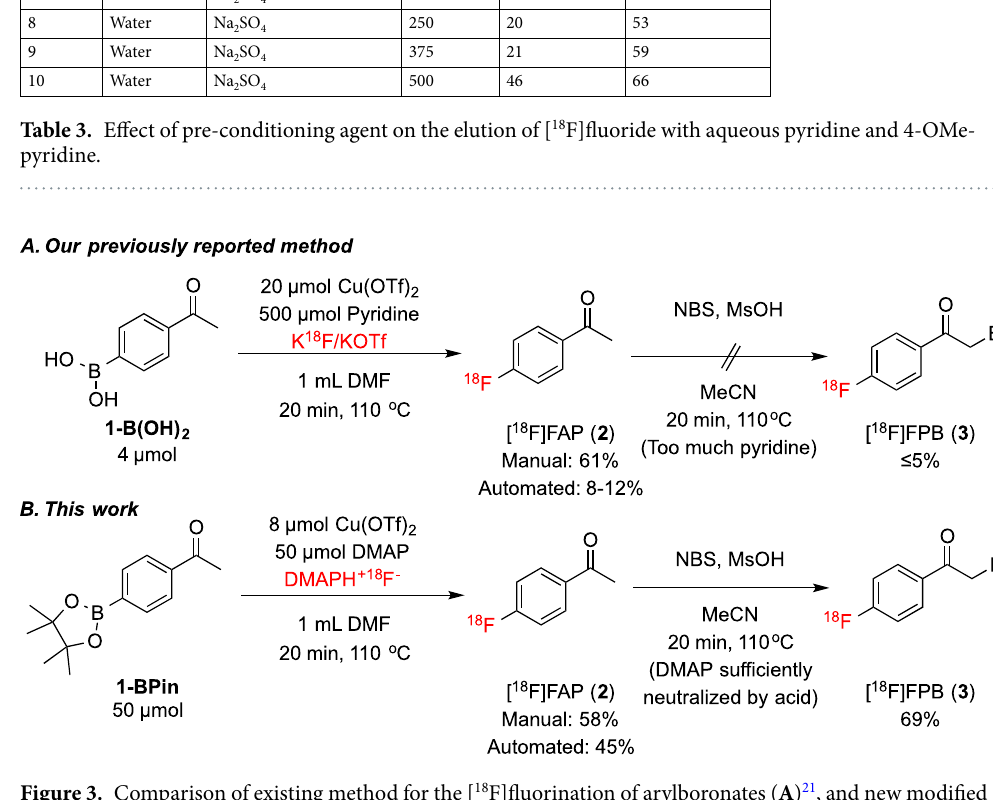
Figure 3. Comparison of existing method for the [ 18 F]fluorination of arylboronates ( A ) 21 , and new modified method ( B ). Changing the base from pyridine to DMAP is necessary for successful one-pot acid-catalyzed bromination of [ 18 F]FAP ( 2 ) to [ 18 F]FPB ( 3